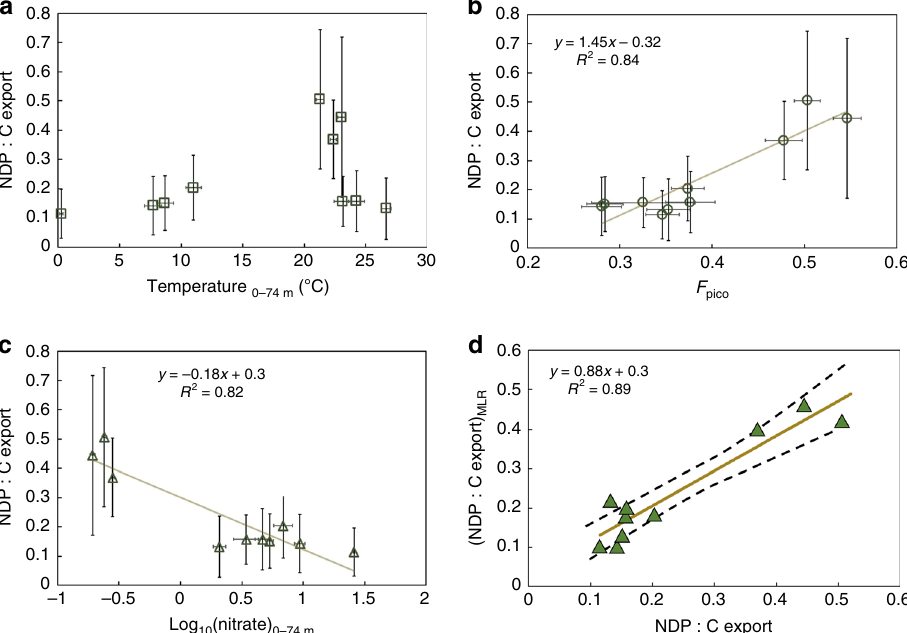
Fig. 5 Regional relationship between DOC production:C export and several environmental parameters. Our diagnosed NDP:C export in the upper 74 m is plotted against regionally averaged temperature ( a ), F pico (fraction of picoplankton) ( b ) and log 10 (nitrate) ( c ). The diagnosed NDP:C export ratios can be explained using a multilinear regression (MLR) model with two predictor variables ( F pico, and log 10 (nitrate)) ( d ). Error bars in a – c indicate ± 1 standard deviation. Dashed envelope in d is the 95% con fi dence interval of the MLR